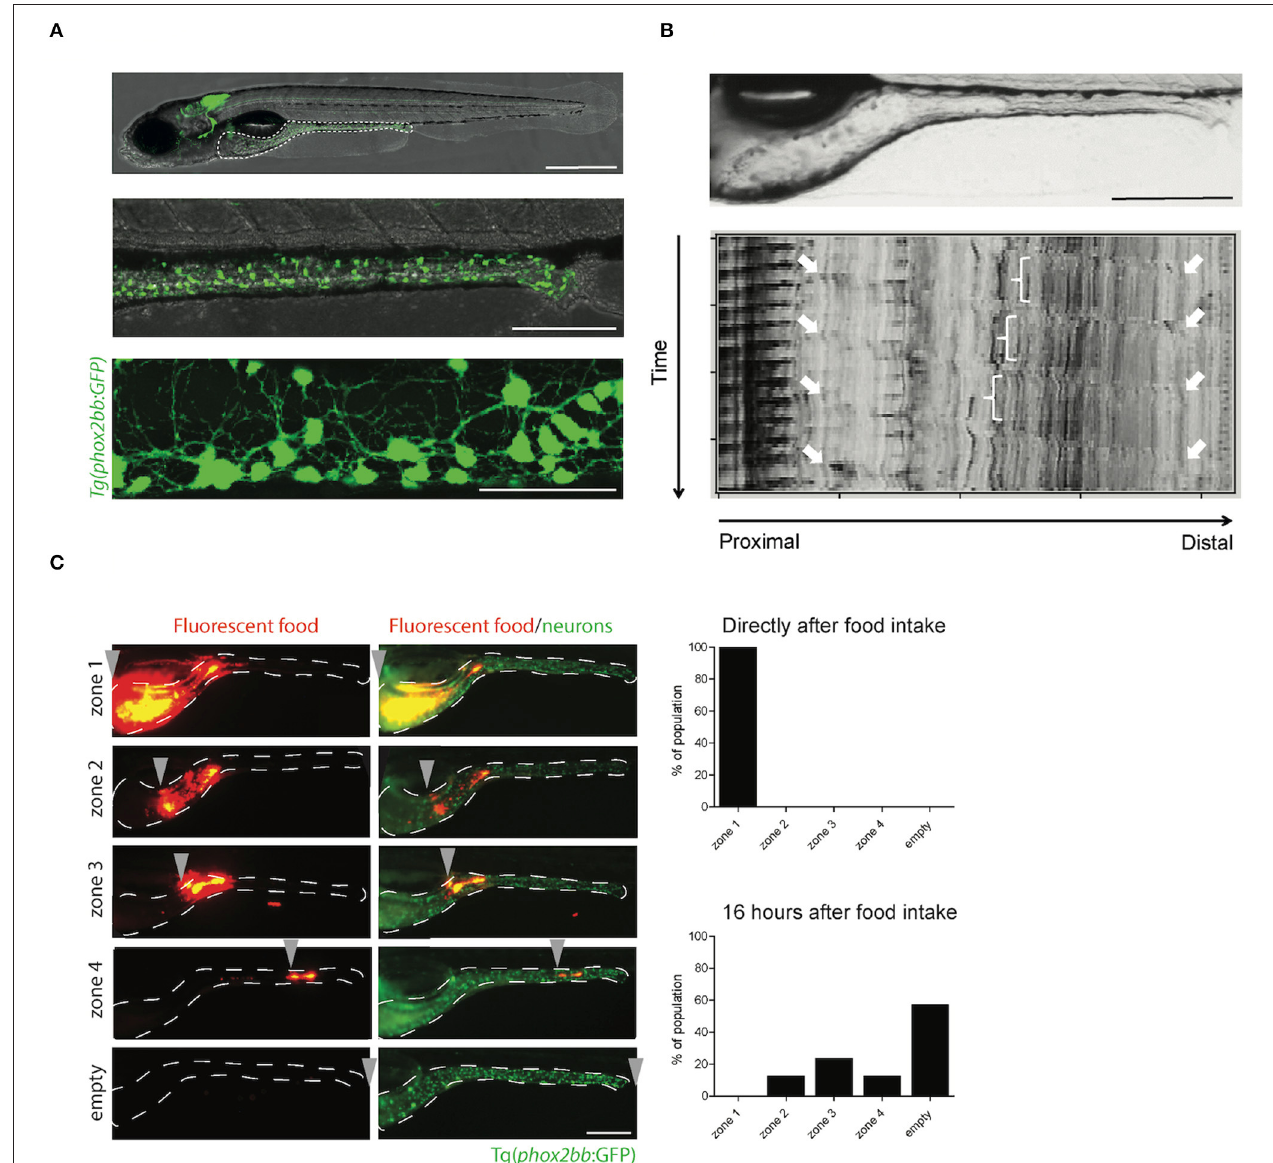
FIGURE 2 | The transparency of zebrafish larvae allows non-invasive visualization of enteric neurons (A) , peristalsis (B) , and gut transit (C) . (A) Microscopy images of Tg( phox2bb :GFP) zebrafish larvae at 5 dpf. Scale bar represents 500 µ m (top), 200 µ m (middle) and 50 µ m (bottom). (B) Still image of the zebrafish intestine (top) and spatiotemporal map (STMap) of gut flow (bottom). Scale bar represents 200 µ m. (C) Microscopic images of Tg( phox2bb :GFP) zebrafish larvae fed with fluorescently labeled food, showing typical intestinal transit and describing the transitional zone. Graphs showing phenotypical scoring of larvae directly after food intake (top graph) and 16h after food intake (bottom graph). Scale bar represents 200 µ